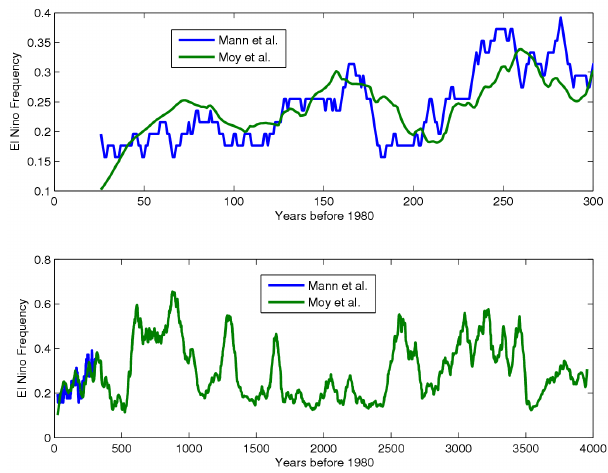
Fig. 6. Comparison between the two ENSO proxies used here dur- ing common years. The agreement between the two records is rather good. Moreover, the bottom panel indicates that the intensity of the stretch of El Nino events starting at about 1450BC is much larger than that observed in the 350 years before present. This would sug- gest that the El Nino signal may have been much stronger at the time of the Minoans. The labeling of the x-axis is as such because the common interval of the two proxies is 1650–1980AD and the window is 50